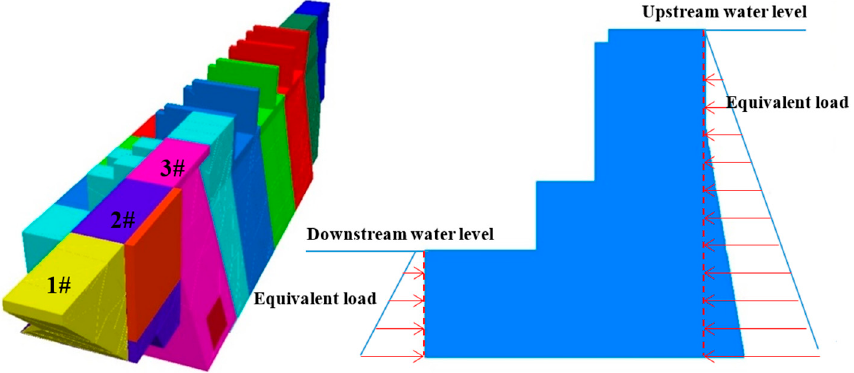
Figure 6. Schematic of the hydrostatic pressure on the upstream and downstream Capulin San Pablo dams.